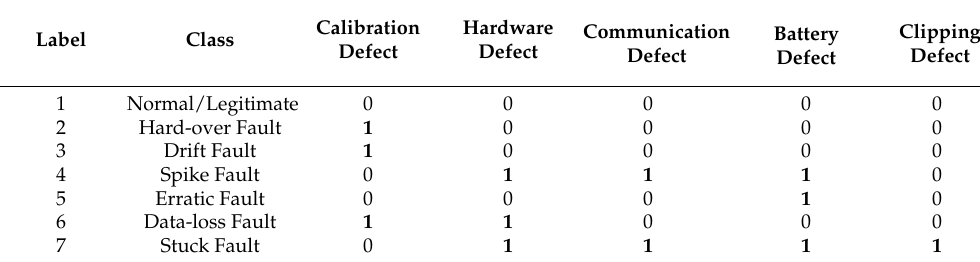
Table 2. Representation of labels for each class according to the